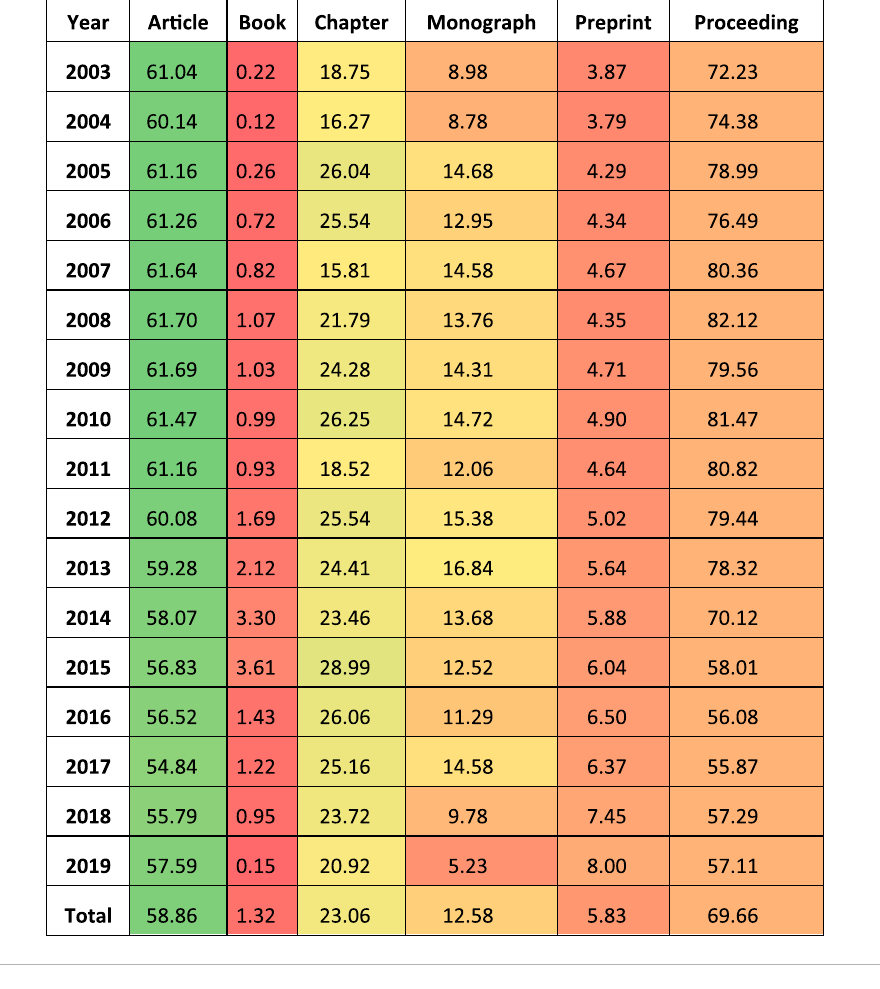
TABLE 3 | Dimensions matching percentages by document type.